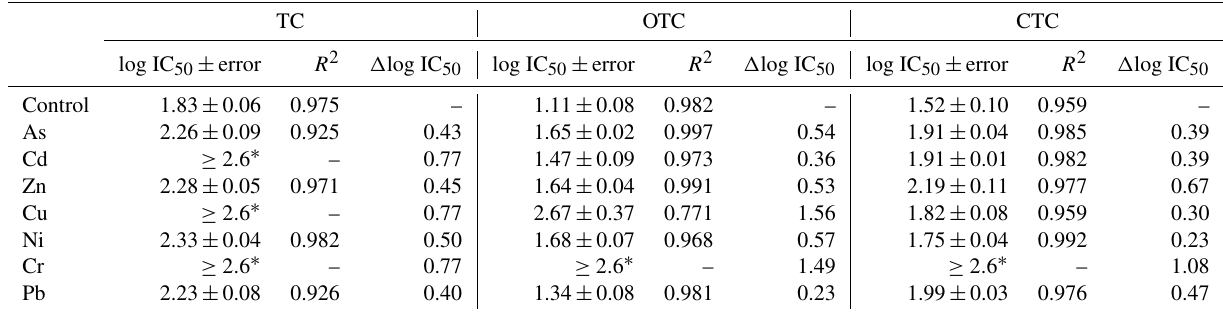
Table 3. Estimated values of log IC 50 ± error and R 2 from fits to a logistic model of soil samples polluted with 1000mgkg − 1 of As, Cd, Zn, Cu, Ni, Cr, and Pb. The increases in tolerance ( (cid:49) log IC 50 = log IC 50 polluted − log IC 50 control) were calculated for tetracycline (TC), oxytetracycline (OTC), and chlortetracycline (CTC).